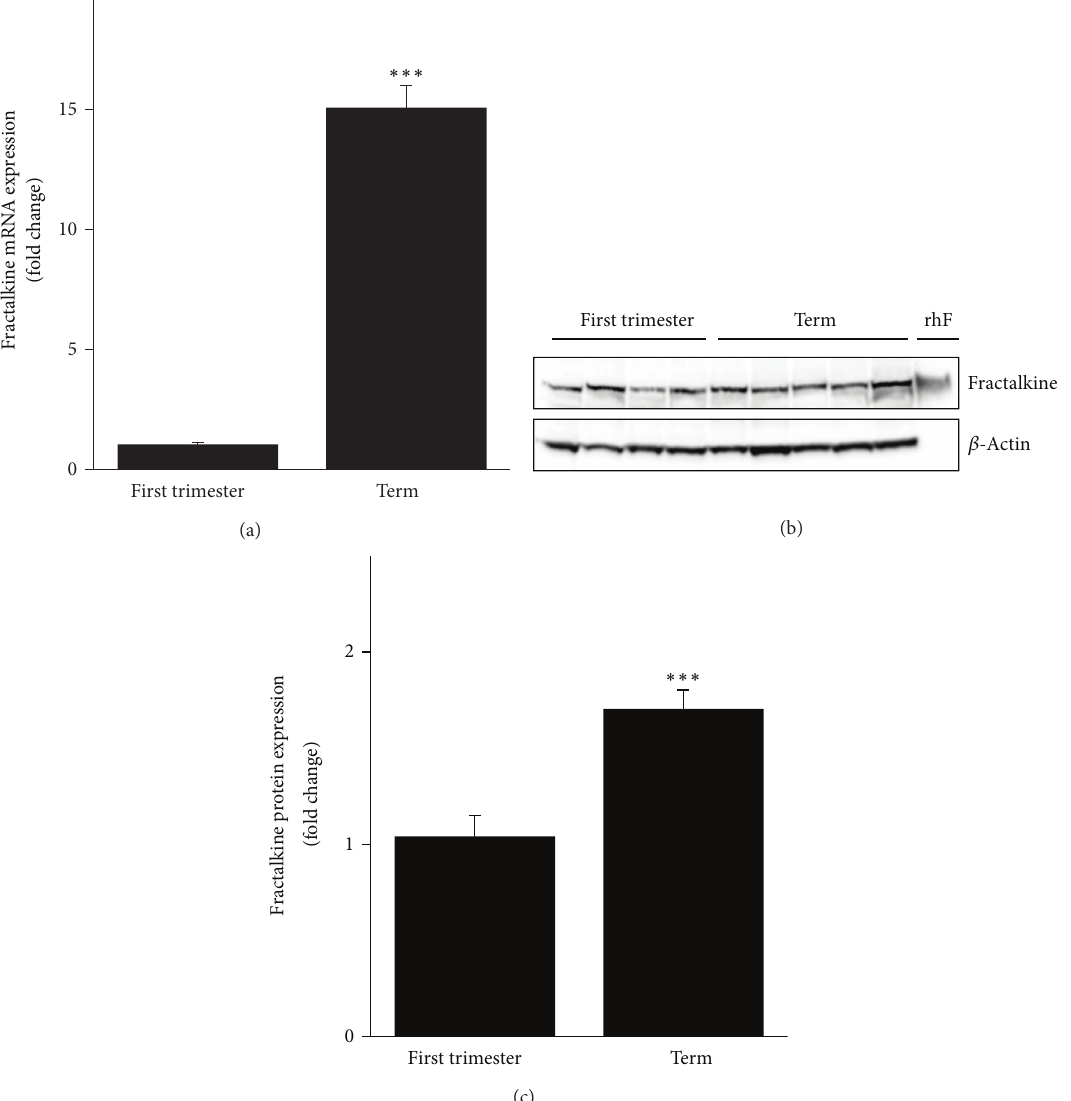
Figure2:Analysisoffractalkineexpressioninhumanfirsttrimesterandtermplacentatissue.Quantitativereal-timeRT-PCRanalysisshowed a15.1-fold( ± 0.9)increaseoffractalkinemRNAexpressioninterm( 𝑛 = 8 )comparedtofirsttrimester( 𝑛 = 9 )placentaltissues(a).Immunoblot analysis of first trimester and term placenta tissue homogenates detected a protein band, corresponding with recombinant 90 kDa human full length fractalkine (rhF), which was applied as positive control. Shown is one representative immunoblot (b). Semiquantitative band analysis revealed a 1.7-fold ( ± 0.1) increase in fractalkine protein expression at term ( 𝑛 = 7 ) compared to first trimester ( 𝑛 = 8 ) (c). Values are given as mean ± SEM. ∗∗∗ 𝑃 ≤ 0.001